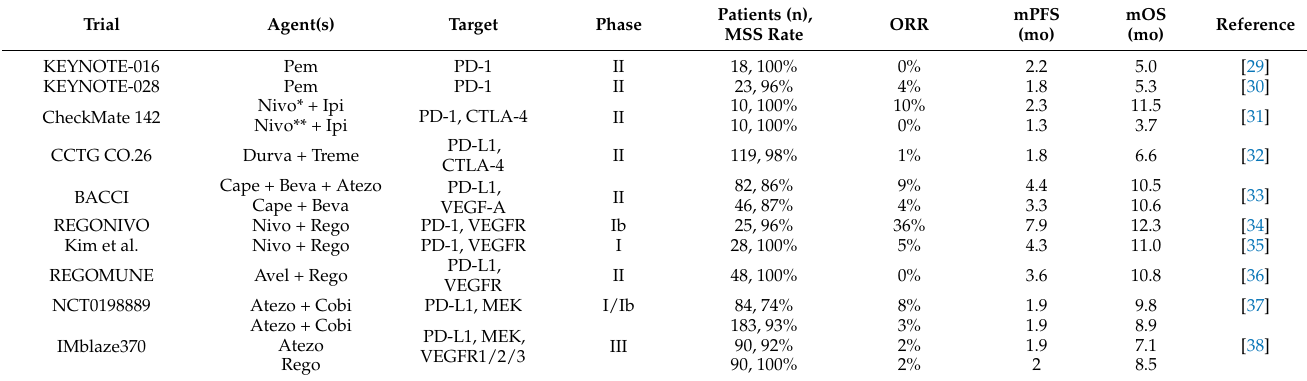
Table 1. Clinical trials using ICIs in patients with MSS/pMMR